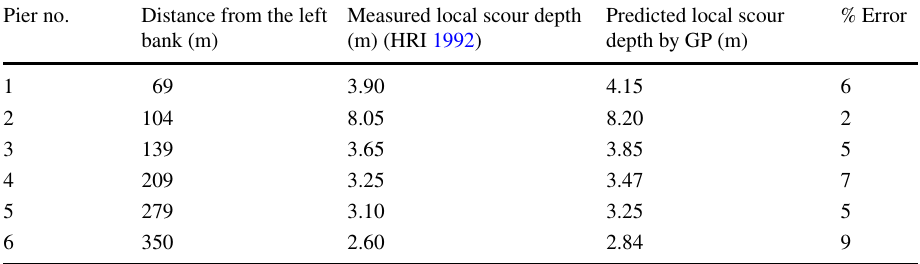
equation for Nile River conditions at Imbaba